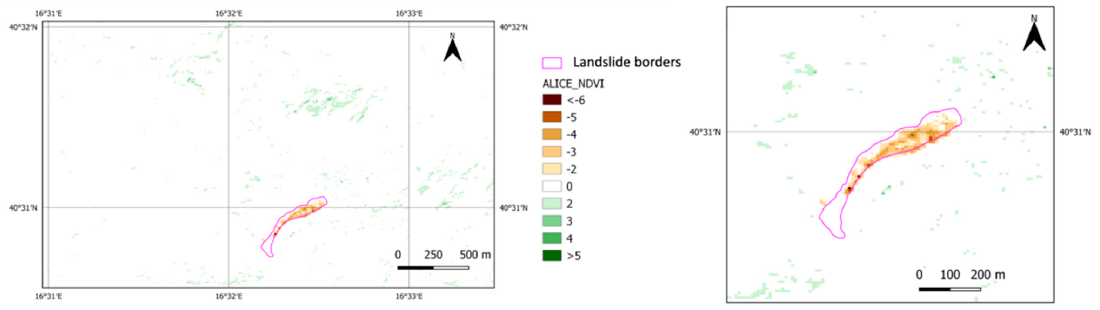
Figure 6. Landslide borders vector obtained by in-field surveys [31] overlapped with the ⊗ NDVI ( x,y,t ) map image. map